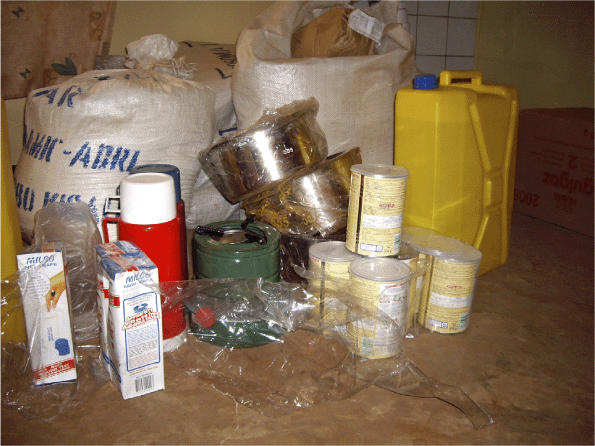
Components of the Package for Prevention of Mother-to-Child Transmission of HIV Provided by Partners In Health/Inshuti Mu Buzima in RwandaPhoto: Ophelia Dahl, Partners In Health